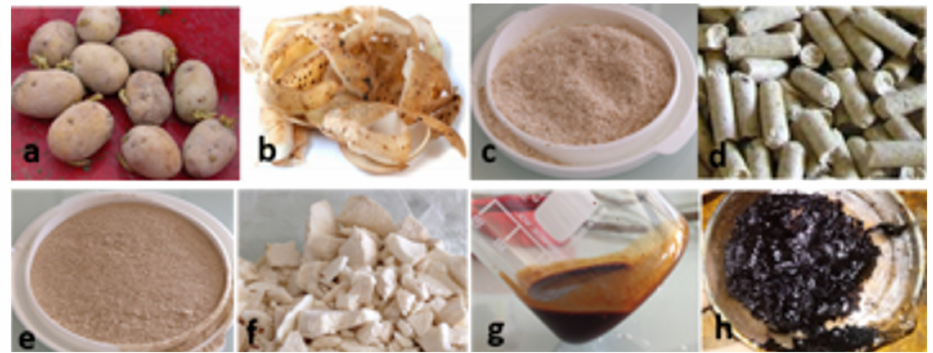
Figure 6. Different samples of potato by-products used in the present work: ( a ) coarse or seed potato (CPo), ( b ) fresh potato peels (FPPe), ( c ) dehydrated potato pulp (DPP), ( d ) coarse potato pulp or “pellets” (PPP), ( e ) ground and sieved pellets (GSP), ( f ) lyophilized flesh potato (LFPo), ( g ) red liquid (RL), and ( h ) lyophilized red liquid